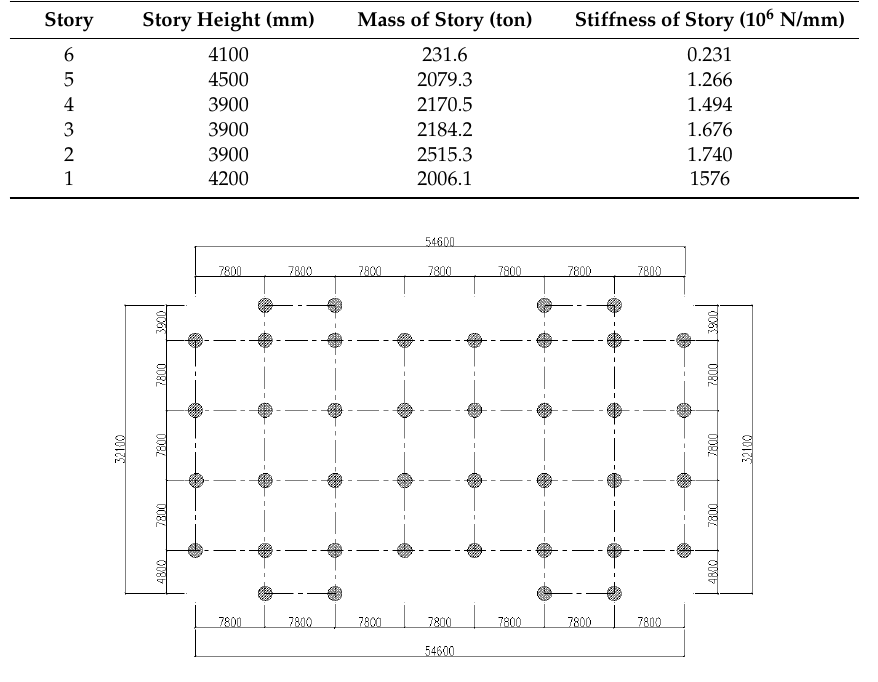
Figure 5. Arrangement of the bearings (mm).